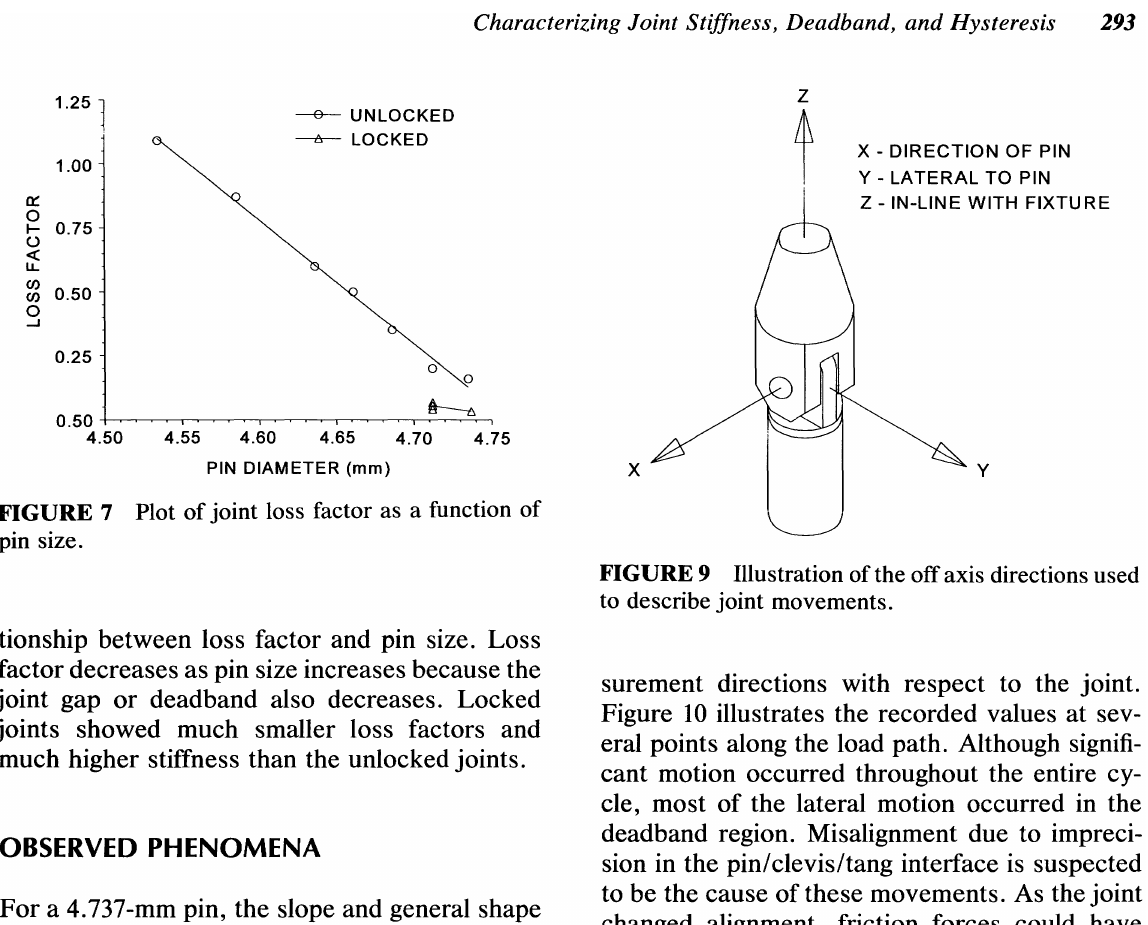
FIGURE 9 Illustration of the off axis directions used to describe joint movements.